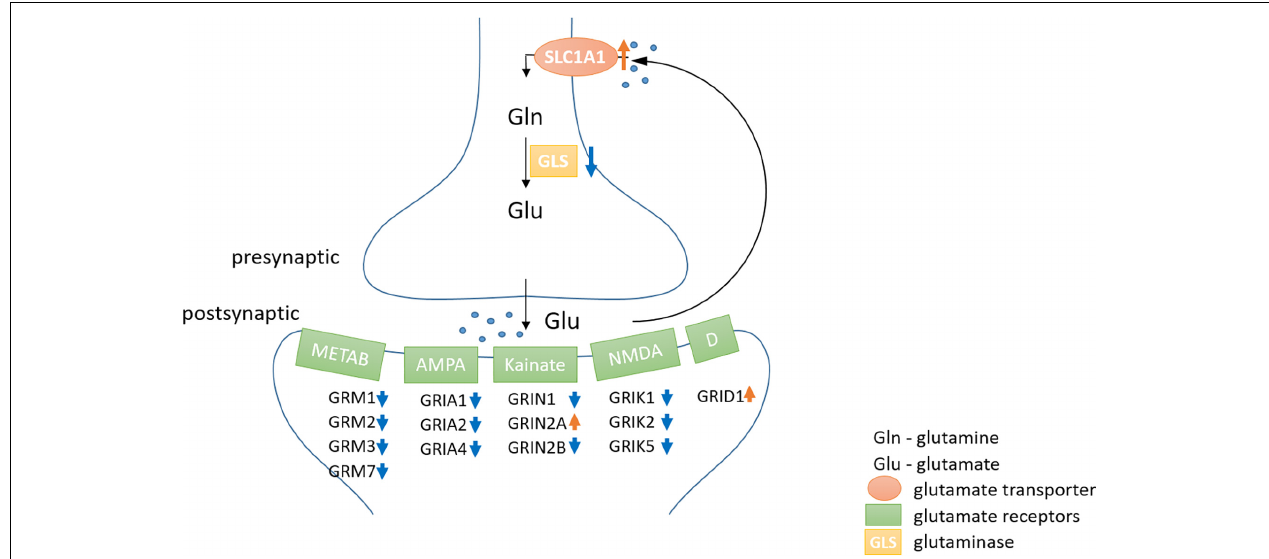
FIGURE 10 | The neuronal part of the glutamate-glutamine-cycle. The majority of metabotropic (METAB) and ionotropic [AMPA, Kainate, NMDA and Delta type (D)] glutamate receptors were lower expressed (blue arrow) in hooded seal neurons, while higher expression is indicated by a red arrow. Astrocytes play an important role in the glutamate-glutamine-cycle, but were not analyzed in this study and thus, were omitted in the